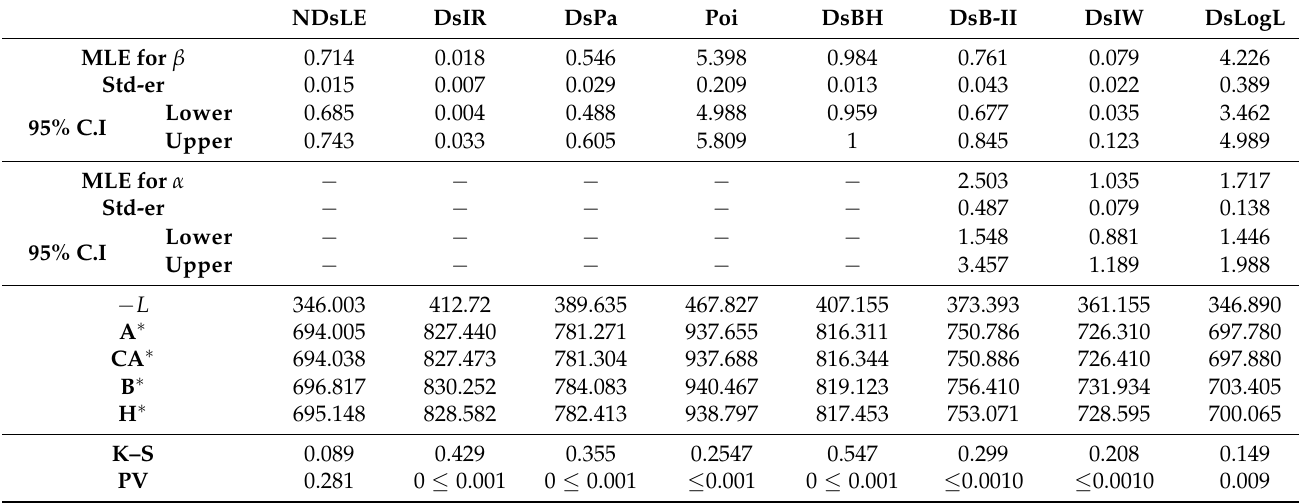
Figure 10. Nonparametric plots for data set II. Table 9. The MLEs, Std-er, C.I, and GOF measures for data set